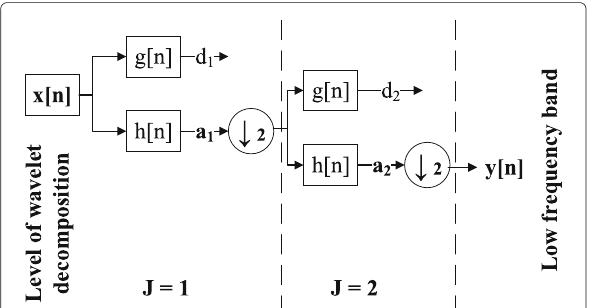
Fig. 2 Multi-resolution wavelet decomposition. The block diagram of the two-channel two-level discrete wavelet transform decomposition ( J = 2) that decomposes a discrete signal into two parts. Note that ↓ 2 is keeping one sample out of two; a i and d i are the approximation and details at level i ,